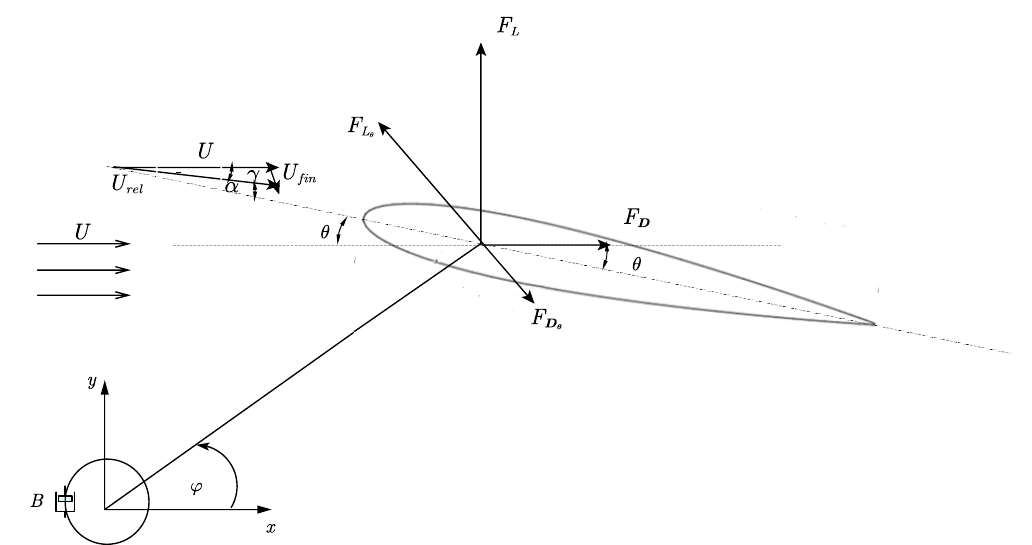
Figure 3. Sketch of the biomimetic stream energy converter with force and velocity vectors.